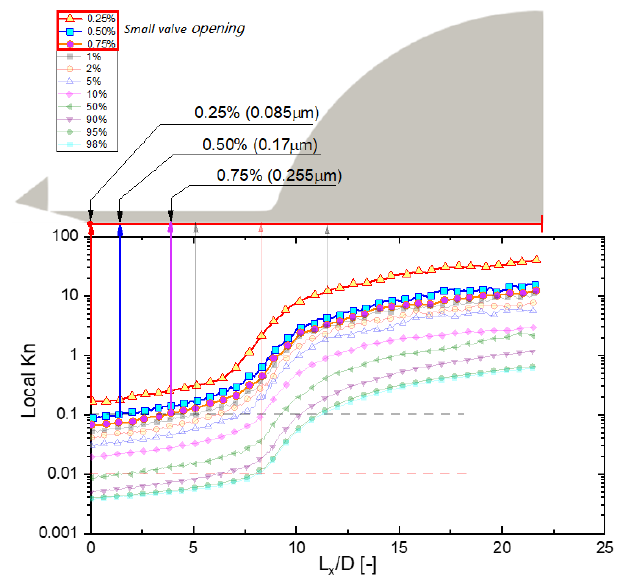
Figure 14. Local Kn distributions along the axis with different valve openings at t = 0.1 ms.